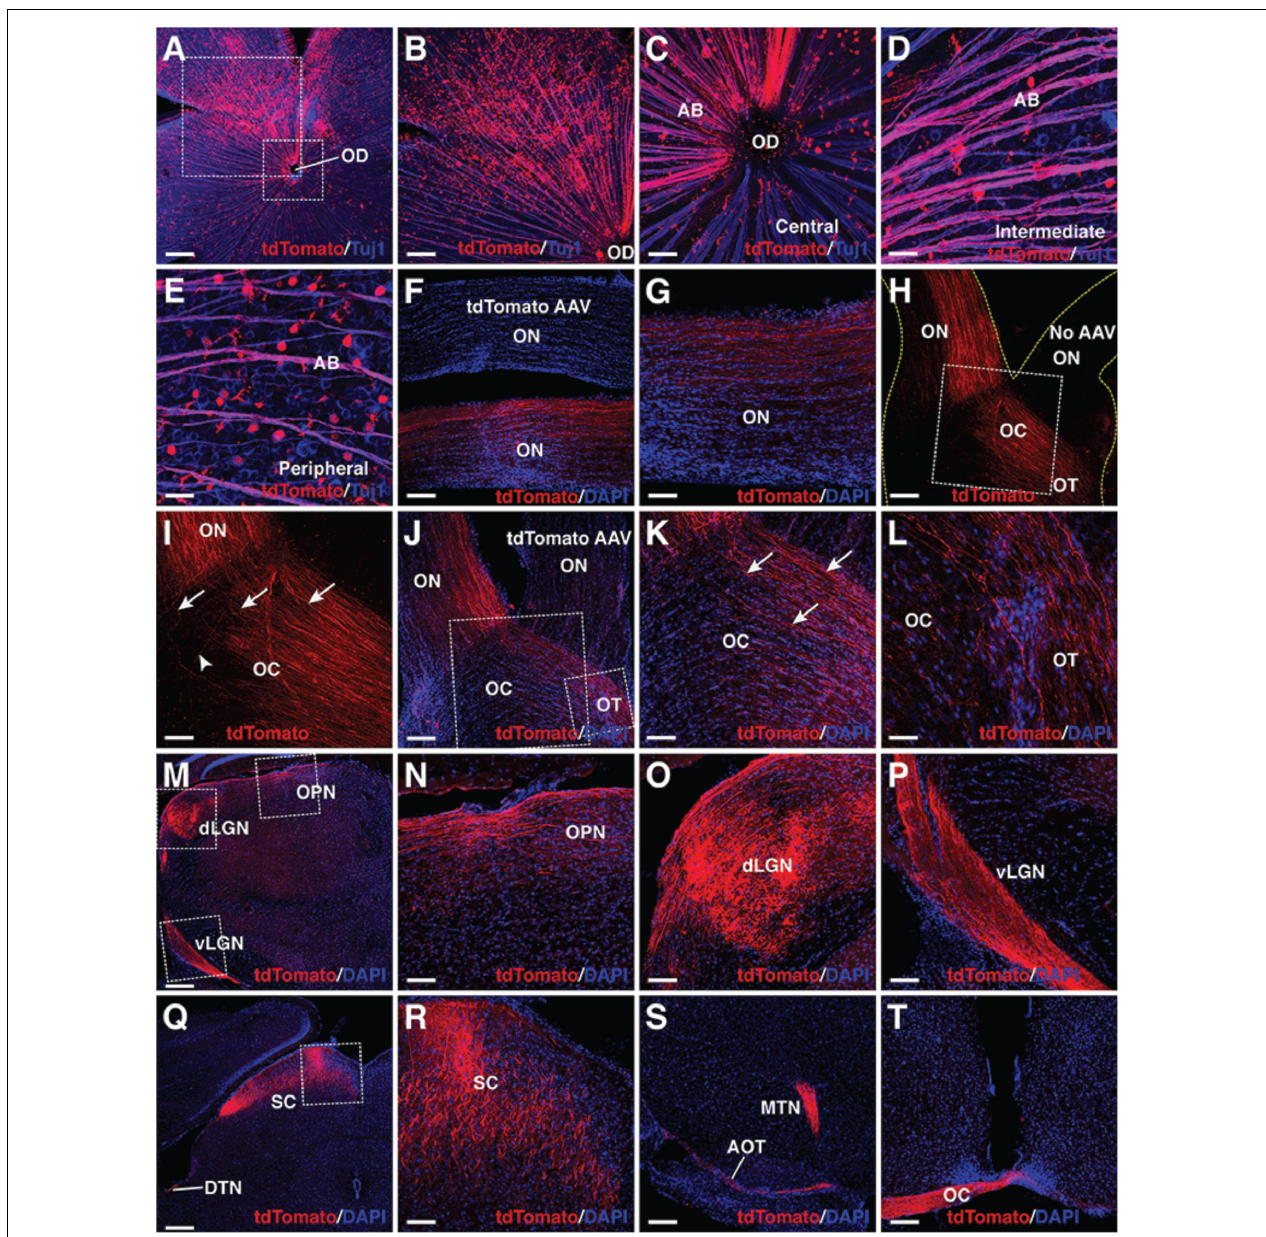
FIGURE 5 | MG-derived RGCs recapitulate the visual projection pathway of endogenous RGCs. (A–E) Flat-mounts of wild-type adult mouse retinas treated with GFAP-Math5-Brn3b-tdTomato AAVs were double-immunolabeled with anti-tdTomato and anti-Tuj1 antibodies. The two areas outlined by the large and small squares in (A) are shown at a higher magnification in (B,C) , respectively. Shown in (C–E) are representative images from the central, intermediate and peripheral retinas, respectively. (F,G) The optic nerves of mice treated with GFAP-Math5-Brn3b-tdTomato or GFAP-tdTomato (tdTomato AAV) AAVs were immunolabeled with an anti-tdTomato antibody and counterstained with DAPI. (H,I) Mono-ocular treatment of adult mice with GFAP-Math5-Brn3b-tdTomato AAVs revealed that tdTomato-immunoreactive axons projected predominantly into the contralateral optic tract. The yellow dashed lines in (H) outline the optic nerve and chiasm regions. The optic nerve from the uninjected eye (No AAV) is indicated. Shown in (I) is a higher magnification view of the region outlined in (H) . Arrows in (I) point to axons crossing the midline of the optic chiasm while the arrowhead indicates a non-crossing axon. (J–L) The optic nerves, optic chiasms and optic tracts of mice treated with GFAP-Math5-Brn3b-tdTomato AAVs in one eye and GFAP-tdTomato AAVs in the other were immunolabeled with an anti-tdTomato antibody and counterstained with DAPI. The two areas outlined by the large and small squares in (J) are shown at a higher magnification in (K) and (L) , respectively. Arrows in (K) point to axons crossing the midline of the optic chiasm. (M–T) Brain areas innervated by MG-derived RGCs in mice treated with GFAP-Math5-Brn3b-tdTomato AAVs. Shown in (N–P) are higher magnification views of the corresponding outlined regions in (M) and shown in (R) is a higher magnification view of the region outlined in (Q) . AB, axon bundle; AOT, accessory optic tract; dLGN, dorsal lateral geniculate nucleus; DTN, dorsal terminal nucleus; EF, MG endfoot; MTN, medial terminal nucleus; OC, optic chiasm; OD, optic disk; ON, optic nerve; OPN, olivary pretectal nucleus; OT, optic tract; RGC, retinal ganglion cell; SC, superior colliculus; vLGN, ventral lateral geniculate nucleus. Scale bars = 320 µ m (A,M,Q) , 160 µ m (B,F,H,J,S,T) , 80 µ m (G,I,K,N,O,P,R) , 40 µ m (C–E,L) .